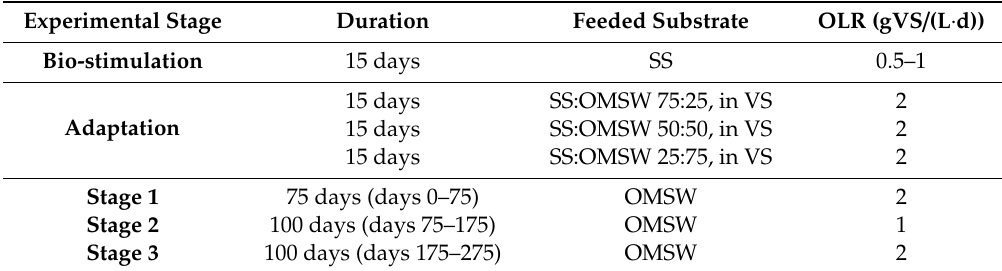
Table 2. Experimental